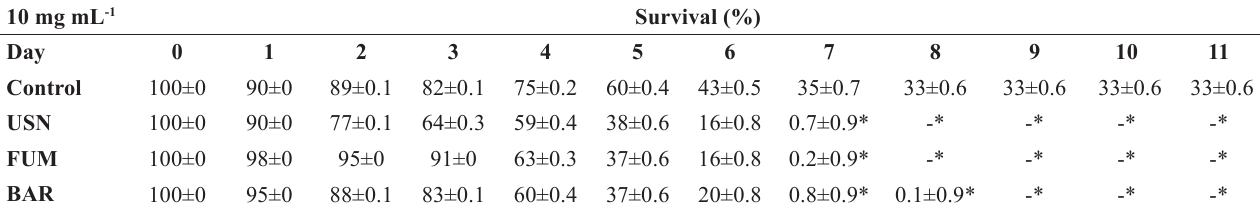
Table 3 . Percentage of termite worker survival following treatment with usnic (USN), fumarprotocetraric (FUM) and barbatic (BAR) acids at concentration of 10 mg mL -1 . Symbol (-) indicates 0% survival. Treatments were compared with the control and among treatments. Asterisk (*) indicates a significance difference at p<